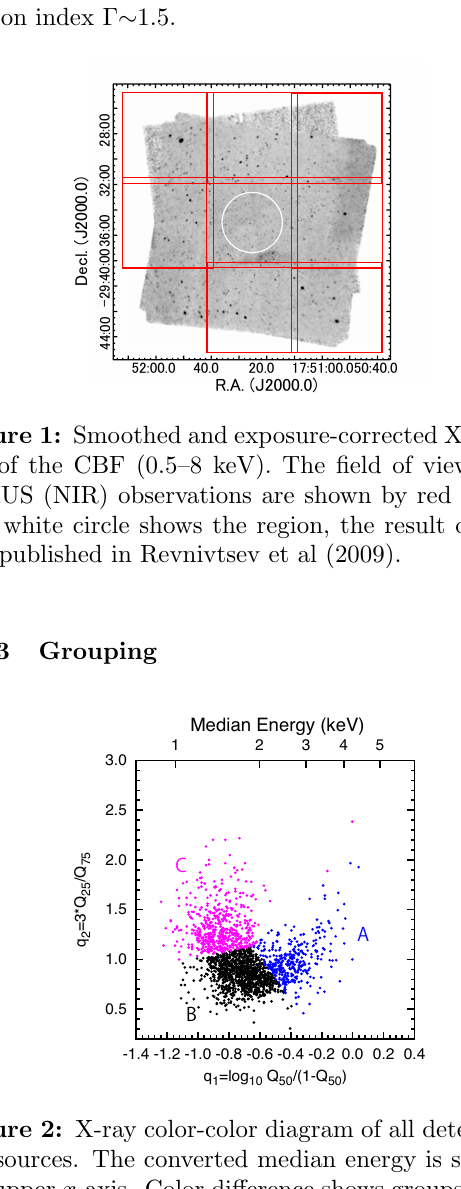
Figure 3: Equivalent width of the Fe K line